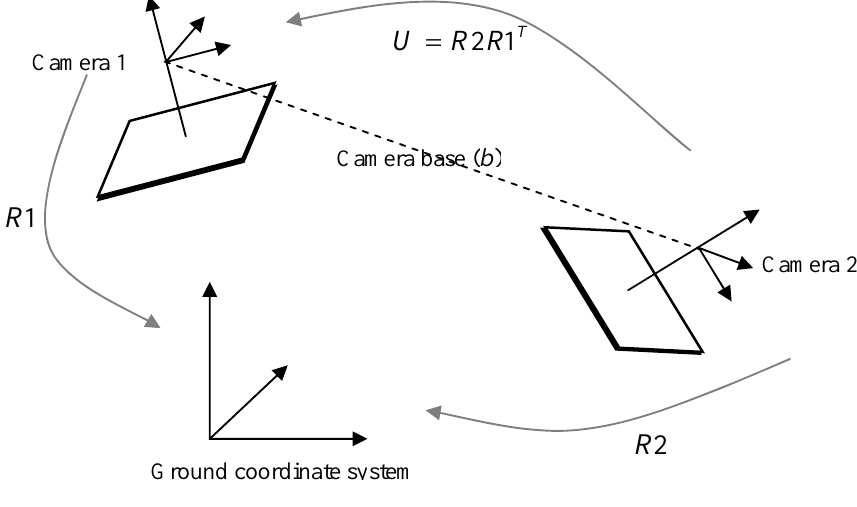
Figure 6. With 3D rotation matrices R1, R2 and U, camera coordinate observations can be rotated to a coordinate system parallel to the target coordinate system. Because 3D rotation matrices are orthogonal, inverse matrices can be calculated with matrix